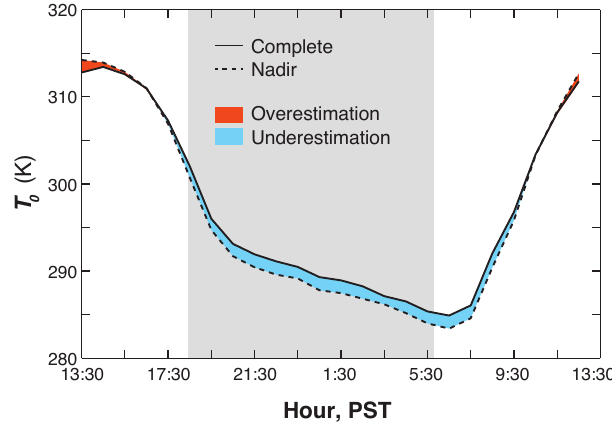
Figure 7. Diurnal course of T 0 , C compared to T 0 , d (φ = 0 ) of a sen- sor with a narrow FOV in the